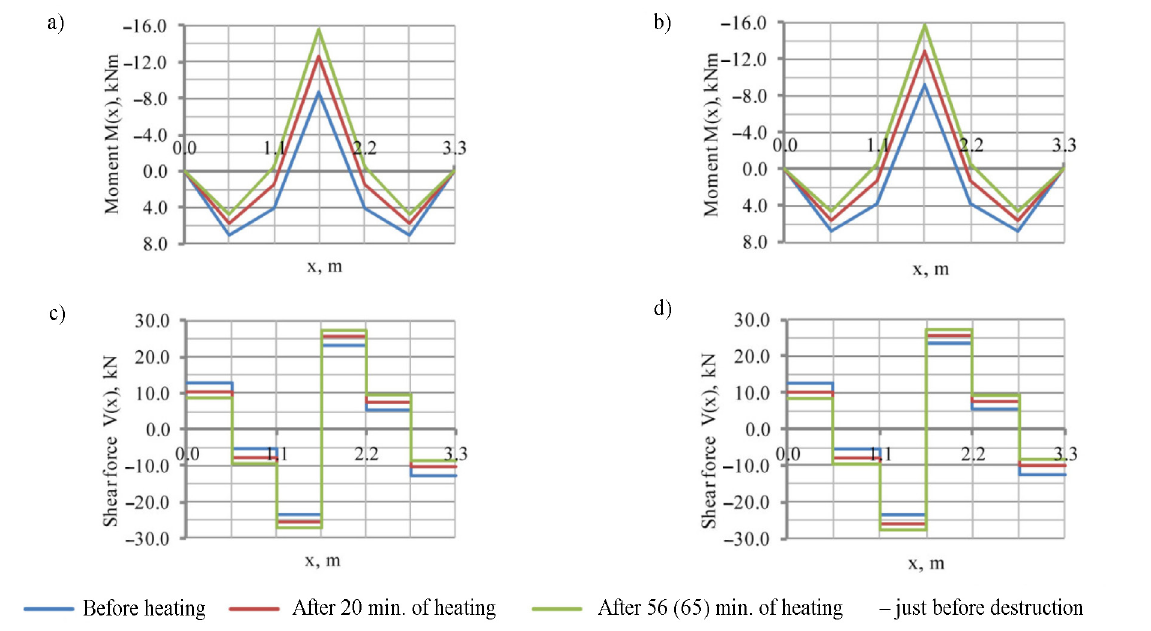
Fig. 7. a), b) Bending moments in two beams in subsequent heating stages, c), d) shear forces in two beams in subsequent heating stages; beam destruction occurred after 56 min (beam 1) and 65 min (beam 2) of